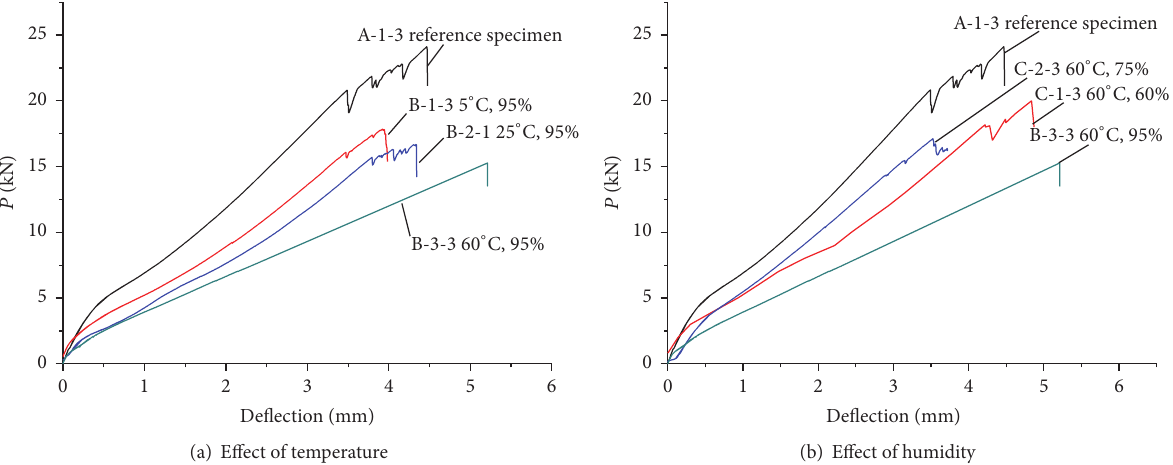
Figure 11: Effect of hot-wet environment on the load-deflection curves.